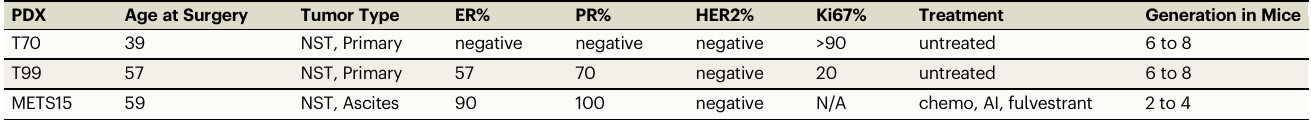
Table 2 | PDXs and corresponding patient tumor characteristics